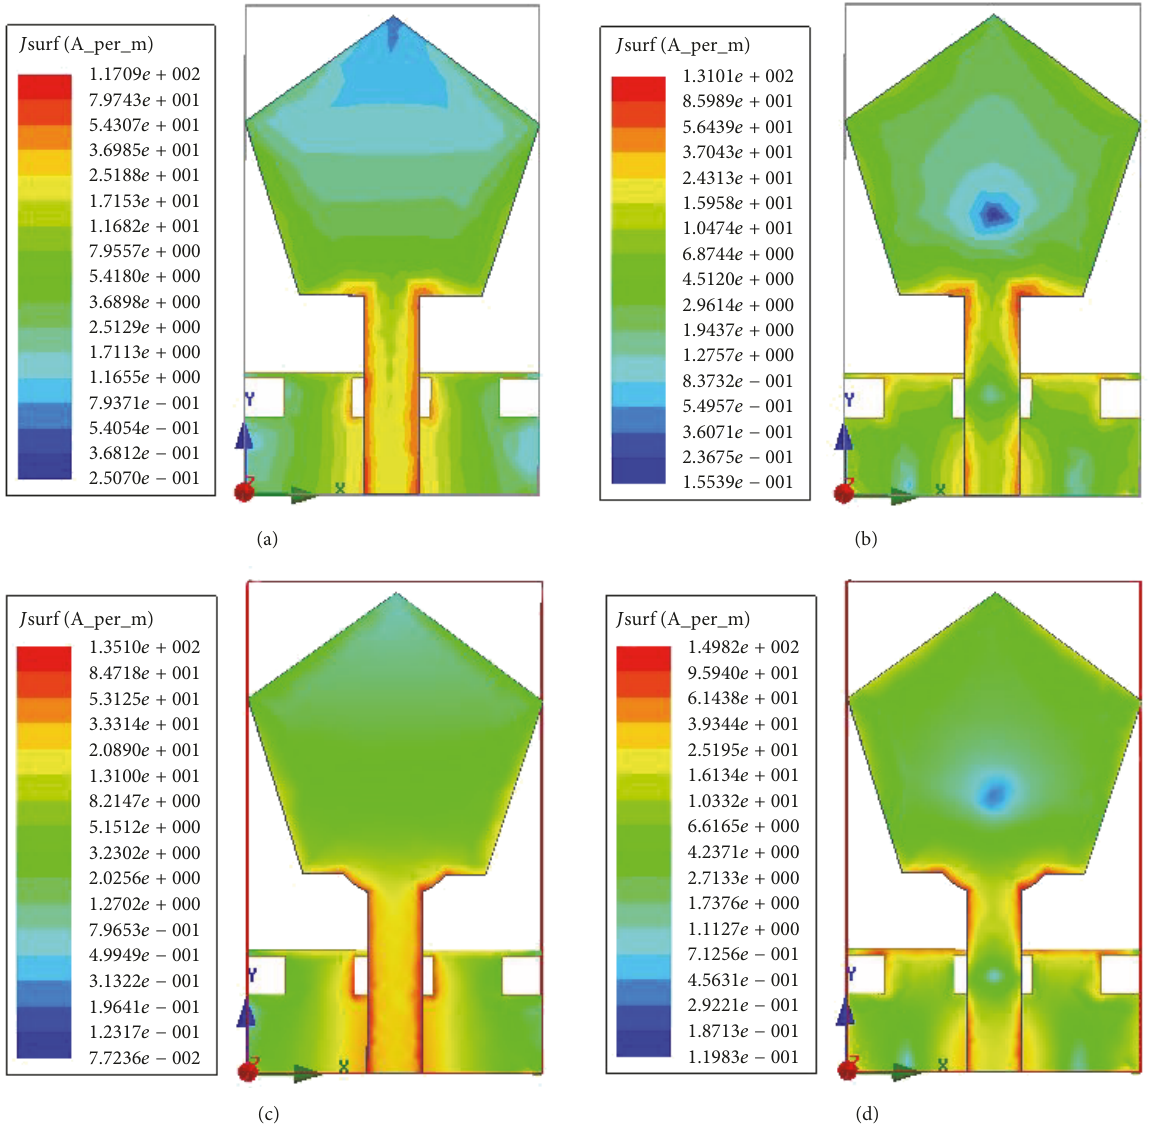
Figure 3: Surface current distributions of PM antenna: without flared feed at (a) 3.1GHz and (b) 10.5 GHz and with flared feed at (c) 3.1GHz and (d) 10.5